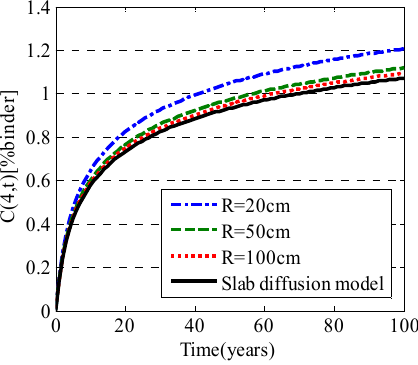
Figure 4. The chloride concentration versus concrete cover thickness at a diffusion time of 100 years.